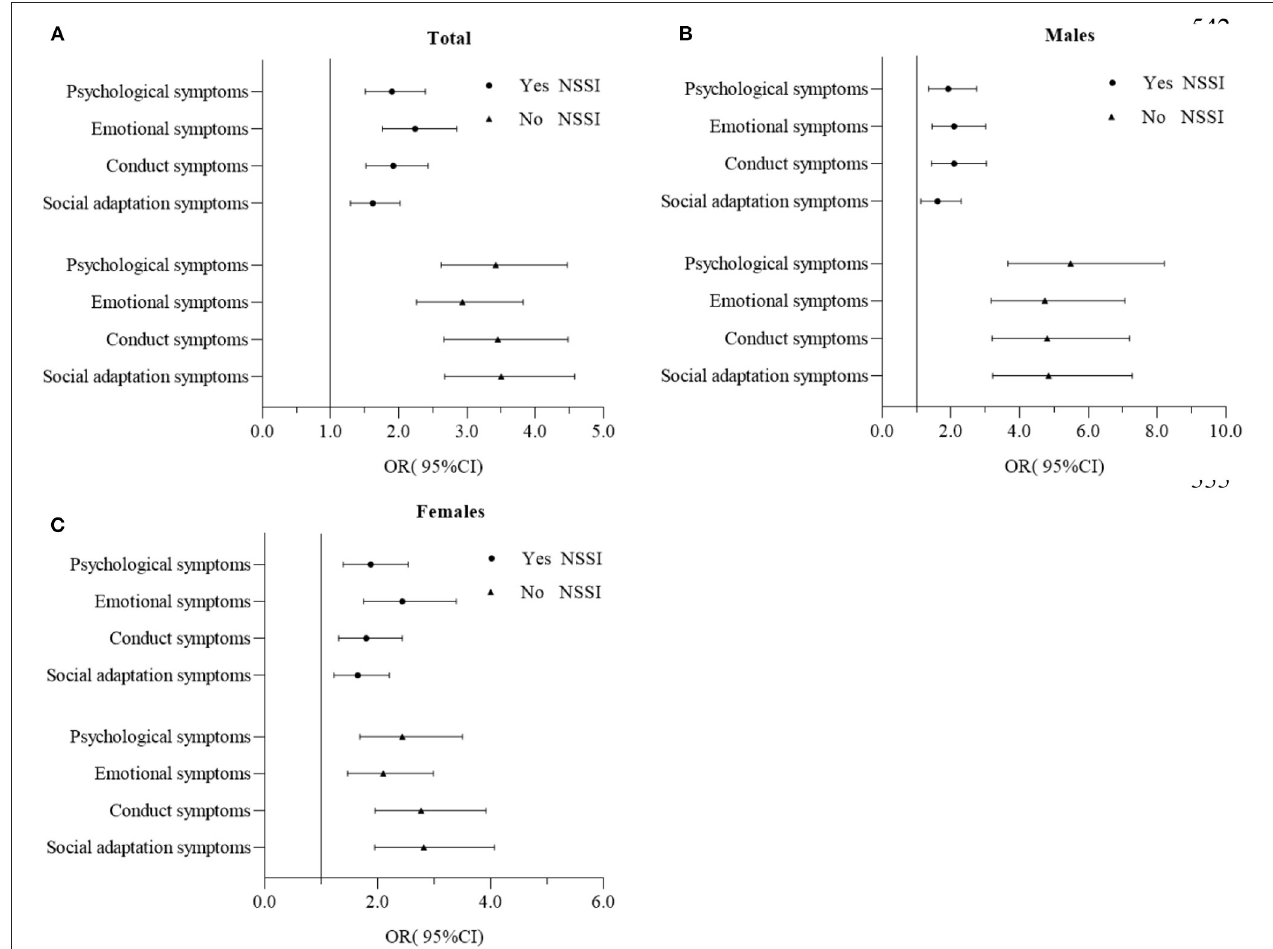
FIGURE 2 | Associations of psychological symptoms with NSSI in (A) total sample (B) males and (C) females, OR(95%CI).